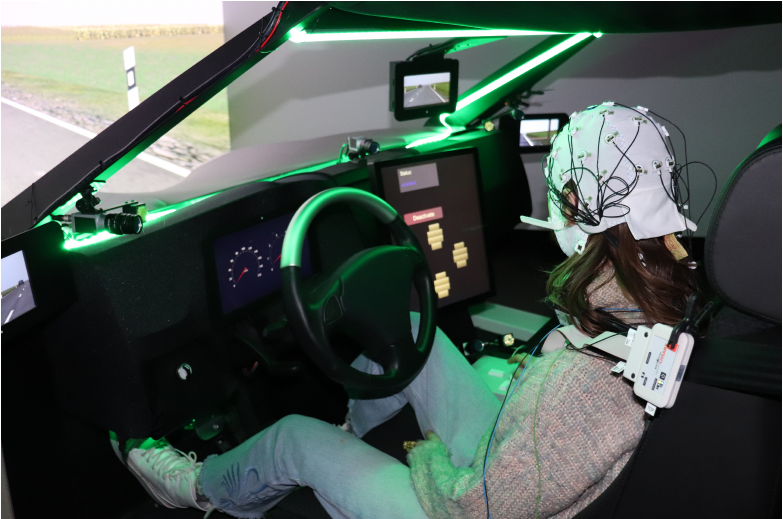
Figure 1. The vehicle mock-up with LED light around the windshield and NDRT presented on the dashboard